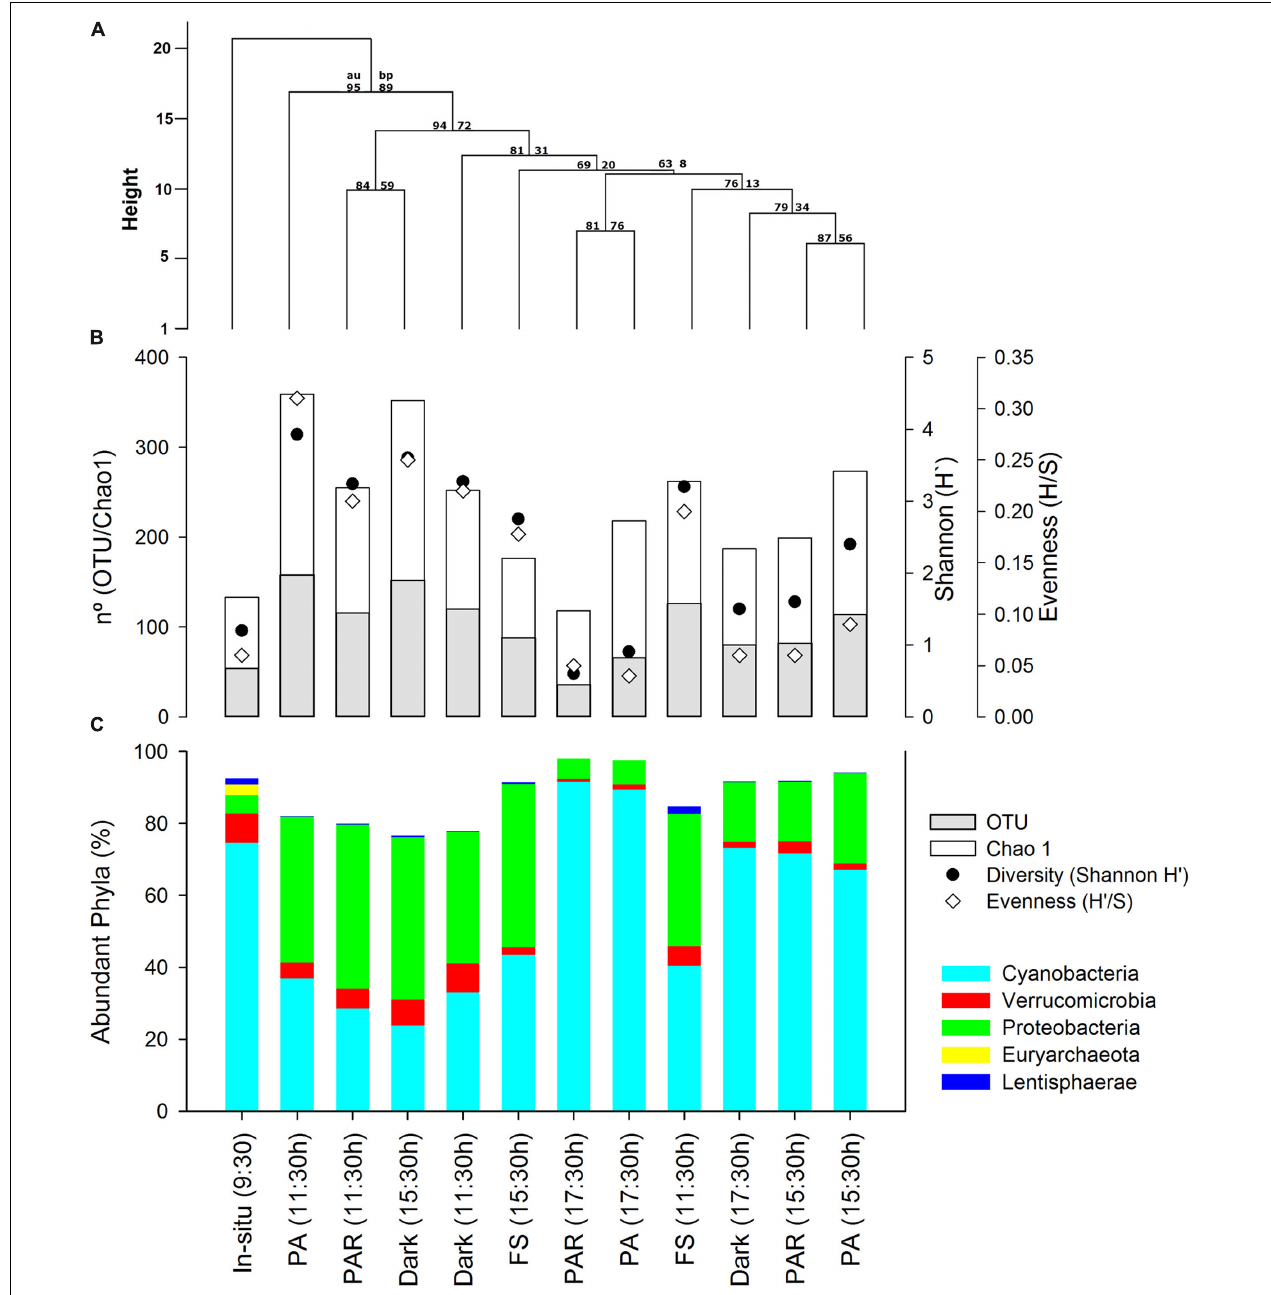
FIGURE 2 | (A) Clustering of active bacteria community structure based on Manhattan distance and average clustering method, also AU (approximately unbiased P -value) and bootstrap values estimated using 1000 resampling are also depicted, (B) Abundant Phyla contribution (%) presented in the same order as clustering analyses results, and (C) plot showing richness, Chao1, Diversity (Shannon H (cid:48) ), and Evenness from the active bacterial community estimated from normalized by resizing pyrolibraries to 1,100 classified